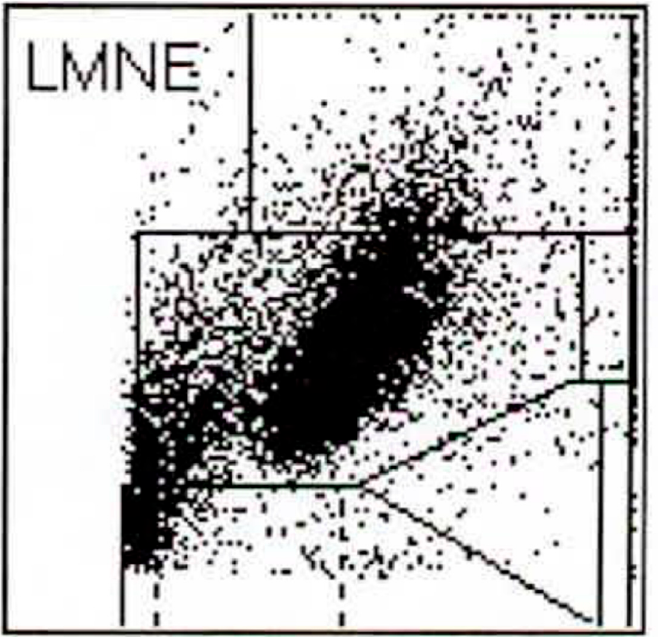
Figure 5. LMNE matrix of a type III (combined type) with one cloud in the area of the neutrophil leukocytes and a second cloud in the NOISE area in a 76-year-old male patient with a periprosthetic joint infection of a total knee arthroplasty. The measured cell count was 5840 cells/ μ L.